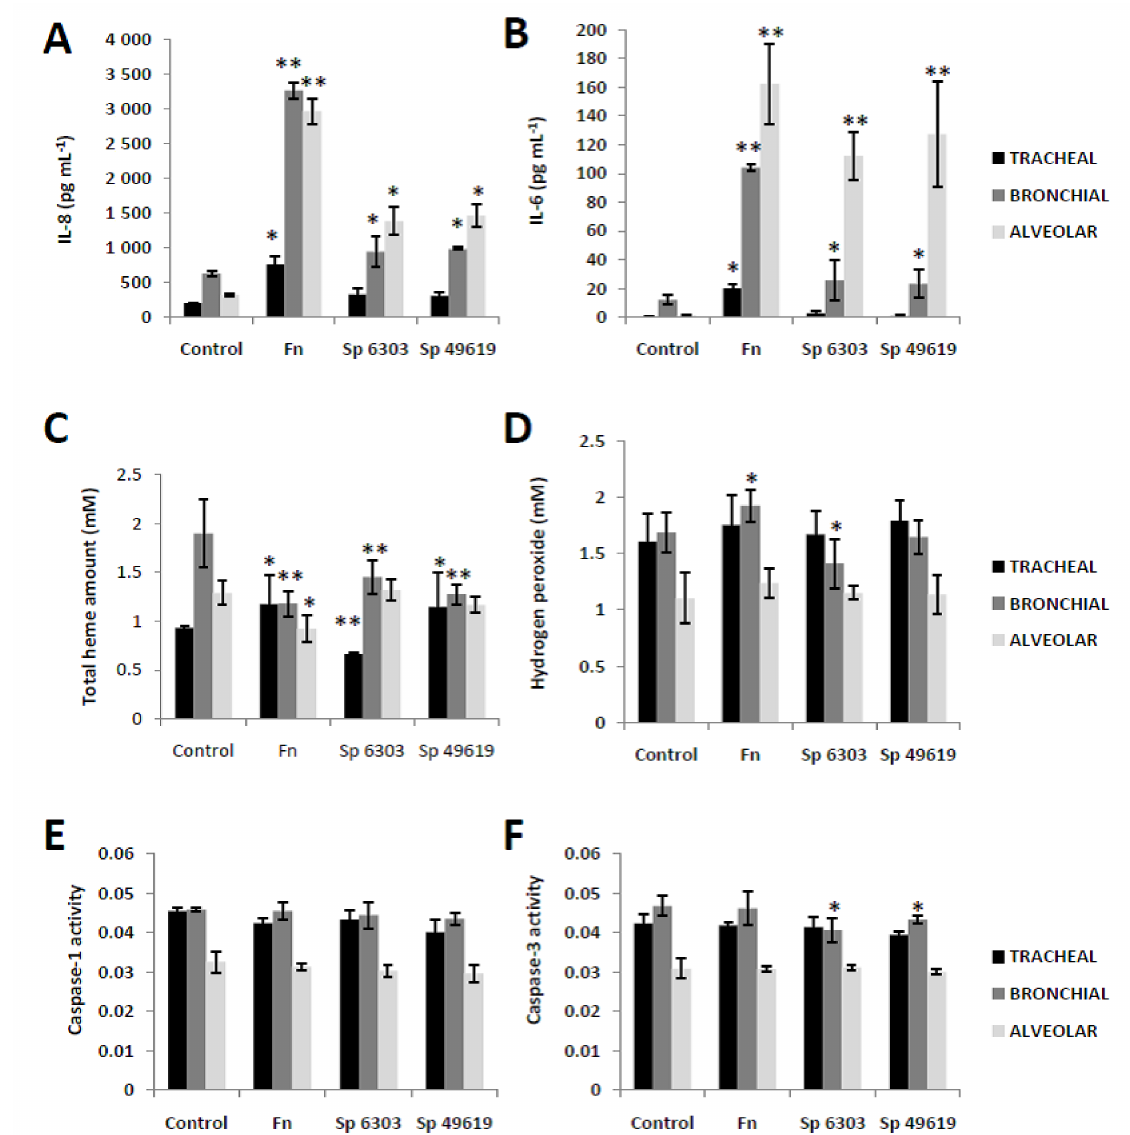
Figure 2. Comparison of inflammatory, stress, and cell death signals secreted from di ff ering primary human respiratory epithelial cells incubated with either heat-killed Fusobacterium nucleatum or Streptococcus pneumoniae . Assay measurements of secreted inflammatory (( A ) IL-8 and ( B ) IL-6), stress (( C ) total heme and ( D ) hydrogen peroxide), and cell death (( E ) caspase-1 and ( F ) caspase-3)signals are shown. Control (only primary epithelial cells), Fn (primary epithelial cells incubated with Fusobacterium nucleatum ), and Sp (primary epithelial cells incubated with either Streptococcuspneumoniae strain 6303 or 49619) are indicated. The results presented are the mean ± SD utilizing two replicates of three independent samples. Statistical analyses were performed using an Andersen–Darling normality test to check whether the values obtained were normalized ( p > 0.05) and, if passed, matched-pair t -test (* p < 0.05; ** p <